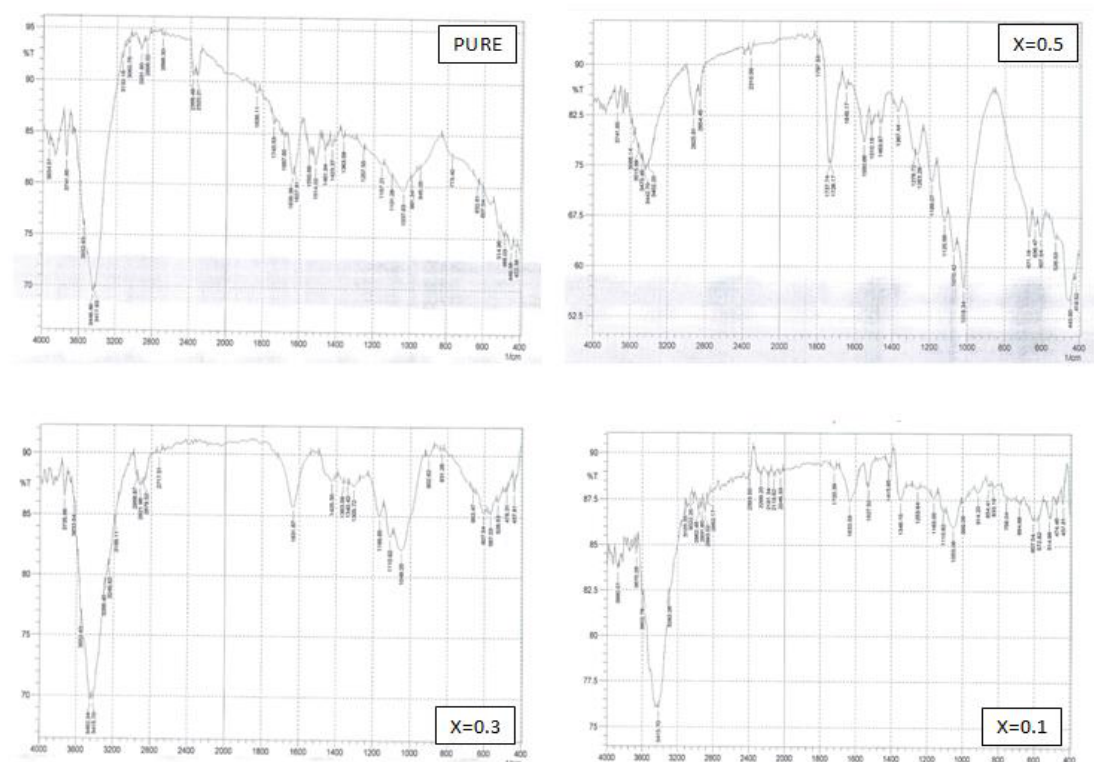
Fig. 2: FTIR pictures for (V 0.3,